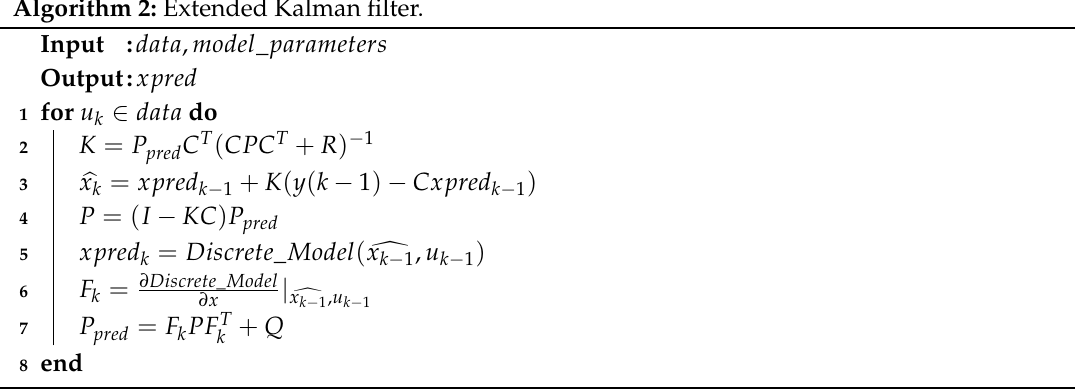
Algorithm 2: Extended Kalman